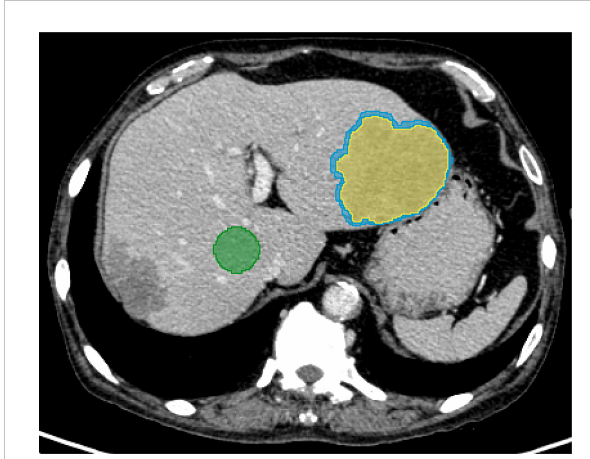
FIGURE 3 A 67-year-old male diagnosed with prostate cancer combined with multiple liver metastases. For evaluating normal liver parenchyma (green), a manual segmentation was performed at the right lobe of the liver. For the liver lesion (yellow), the segmentation was completed layer by layer along the contour of the lesion. Morphological dilation was applied to segment out the peritumor